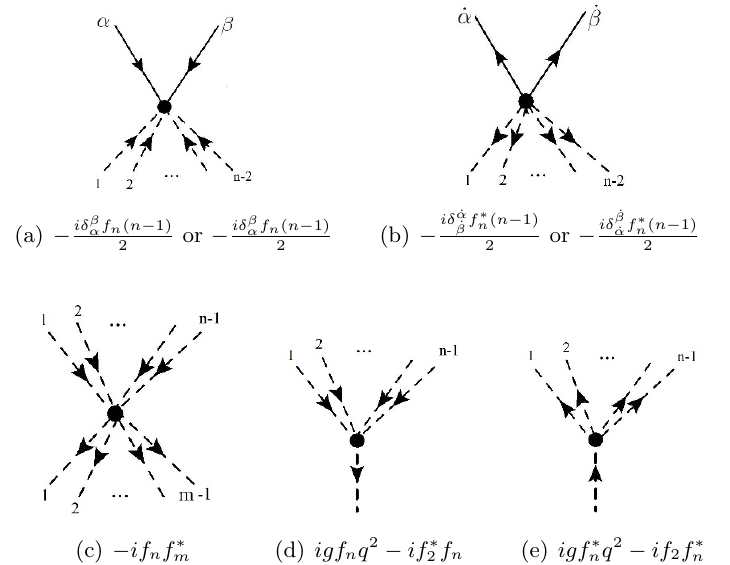
Figure 4 . Feynman rules for a general interaction of the form (2.33). A thick dashed line represents a boson with a spatial momentum ~q insertion. In (cid:12)gures 4(a), 4(b), the choice of which rule to use depends on how the vertex connects to the rest of the diagram considered, and on the index contraction order chosen for the corresponding fermionic